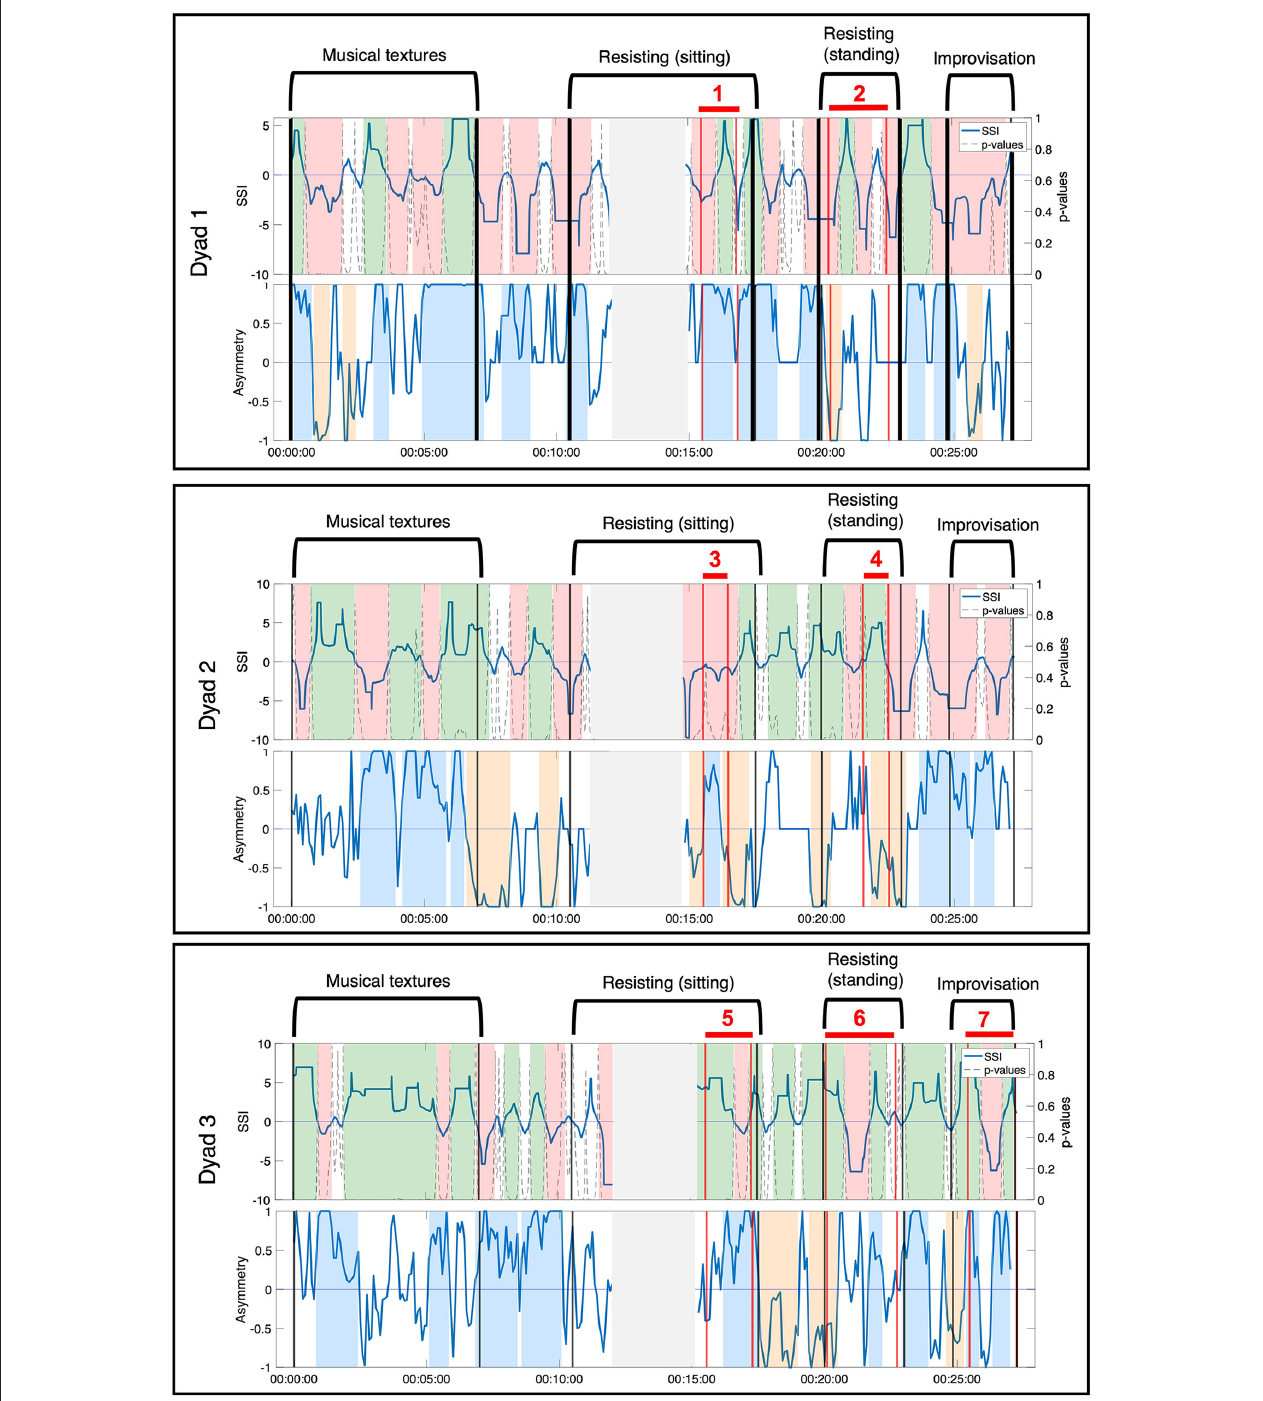
FIGURE 3 | Annotated movement sessions for the three dyads (Dyad 1: Hector and Jean, Dyad 2: Erica and Anne, Dyad 3: Ruth and Harvey). Observed moments of connection are labeled and shown between the vertical red lines. Moments where the sensor disconnected are shown in the gray shaded area.